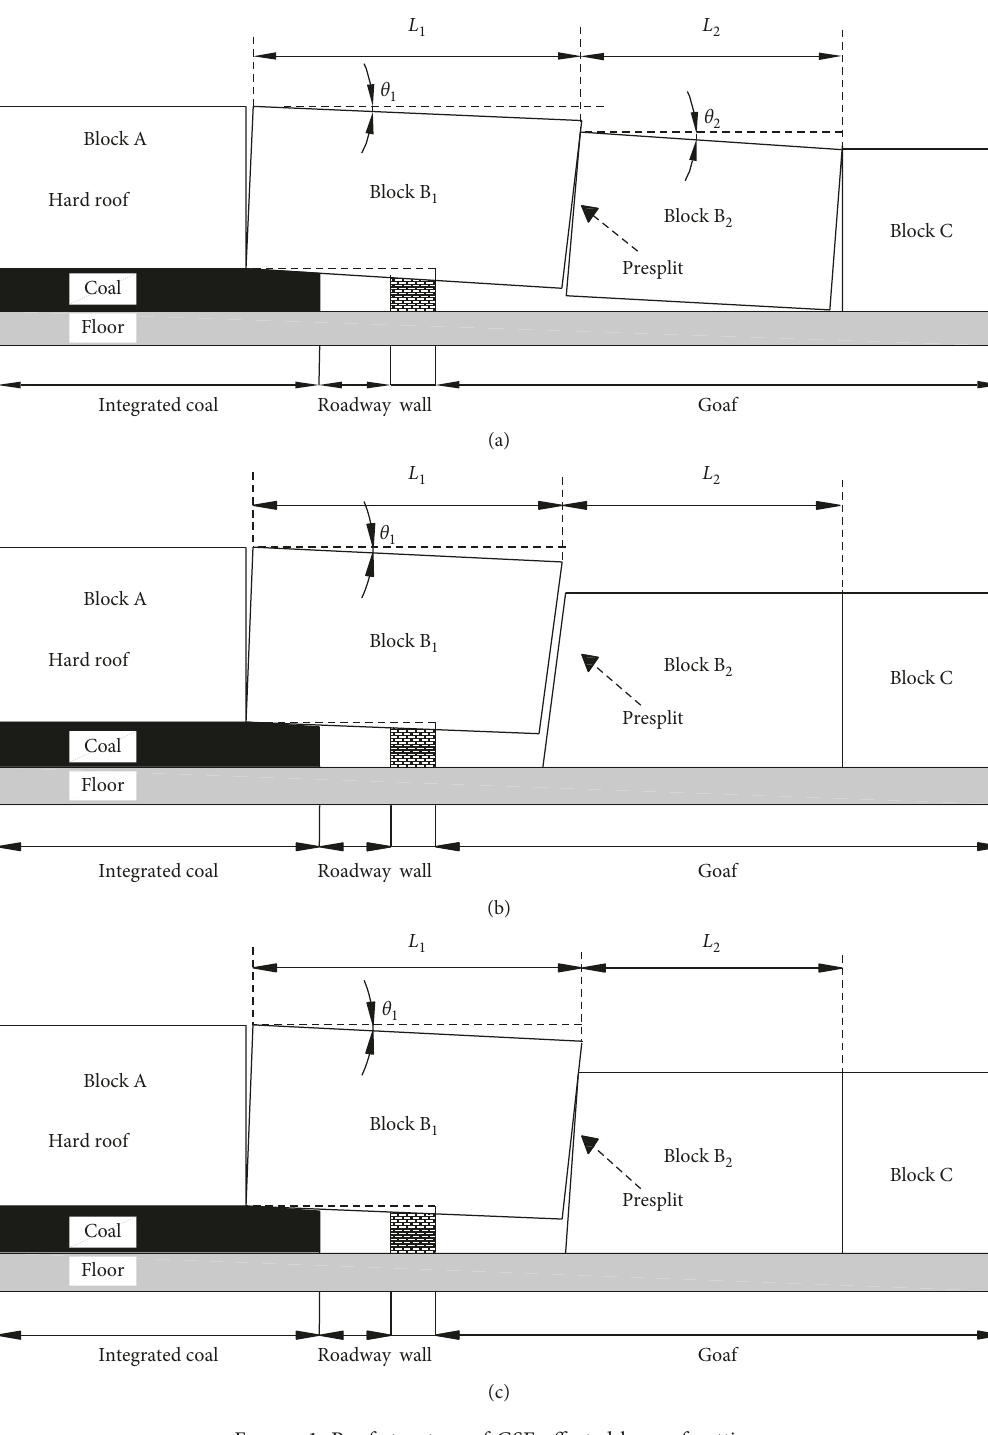
Figure 1: Roof structure of GSE affected by roof